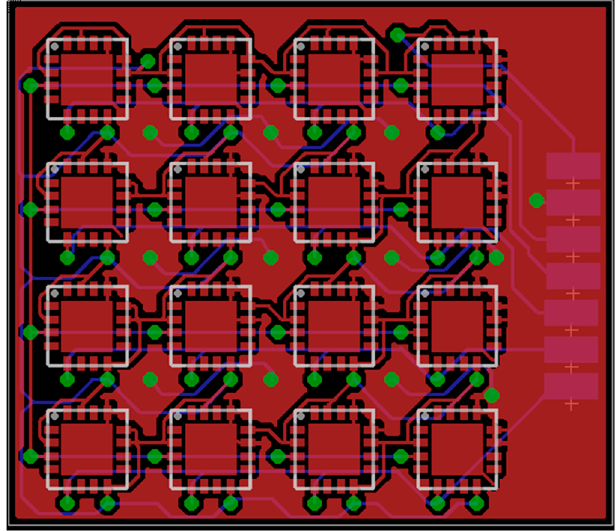
Figure 10. A custom PCB for integrating 16 MLX90393 chips.